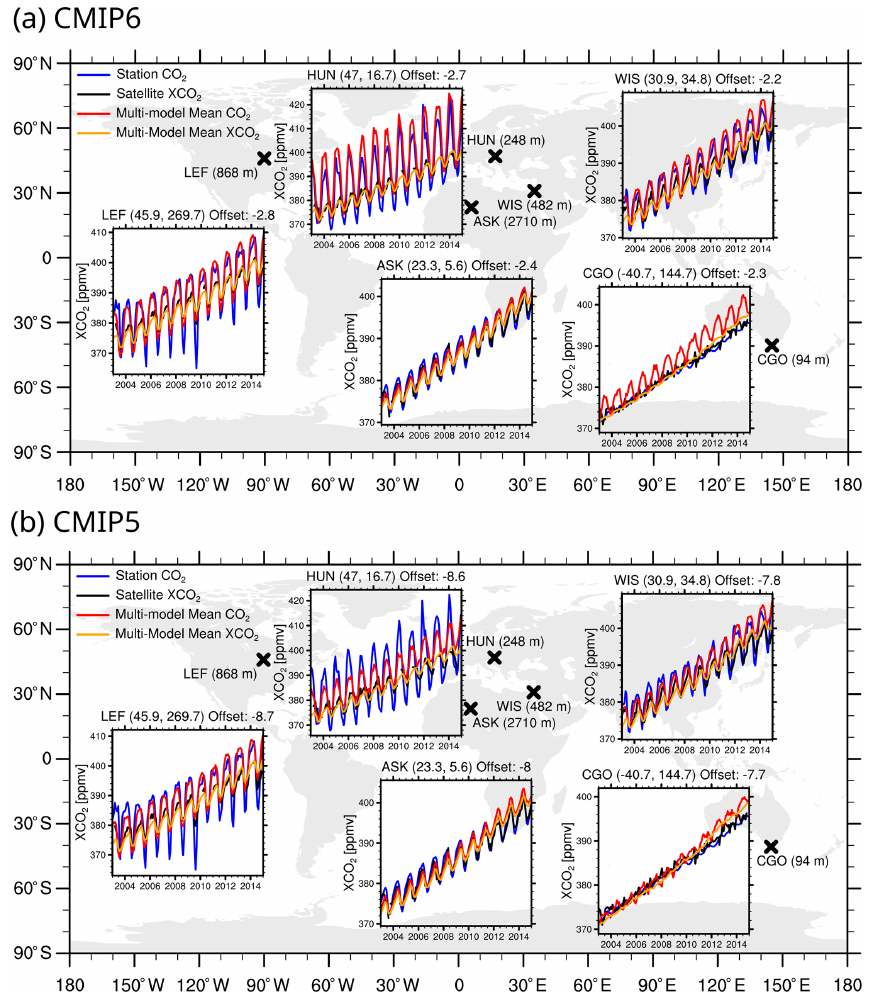
Figure 2. Comparison of time series from satellite XCO 2 (black), multi-model mean XCO 2 (orange) and surface CO 2 (red), and NOAA surface CO 2 station data (blue) at selected sites, with the coordinates noted in brackets above the time series and the altitudes shown in the map plot (see Table 1). The multi-model mean for both XCO 2 and surface CO 2 was offset to have the same average value as the satellite XCO 2 for better comparison, and this offset is noted above each time series. CMIP6 and CMIP5 multi-model means are shown in the top (a) and bottom (b) panels,